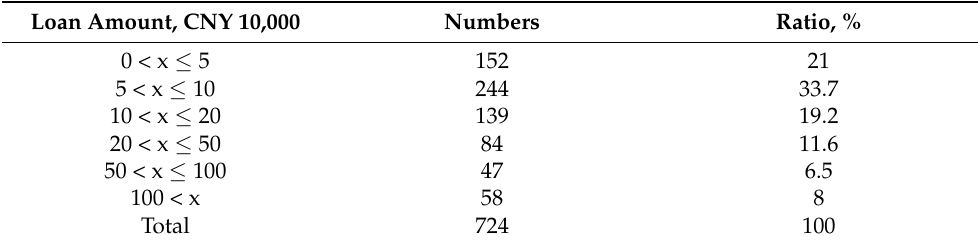
Table 2. Default amount of farmland mortgage loans with the borrower being a company or agri- cultural operation organization.